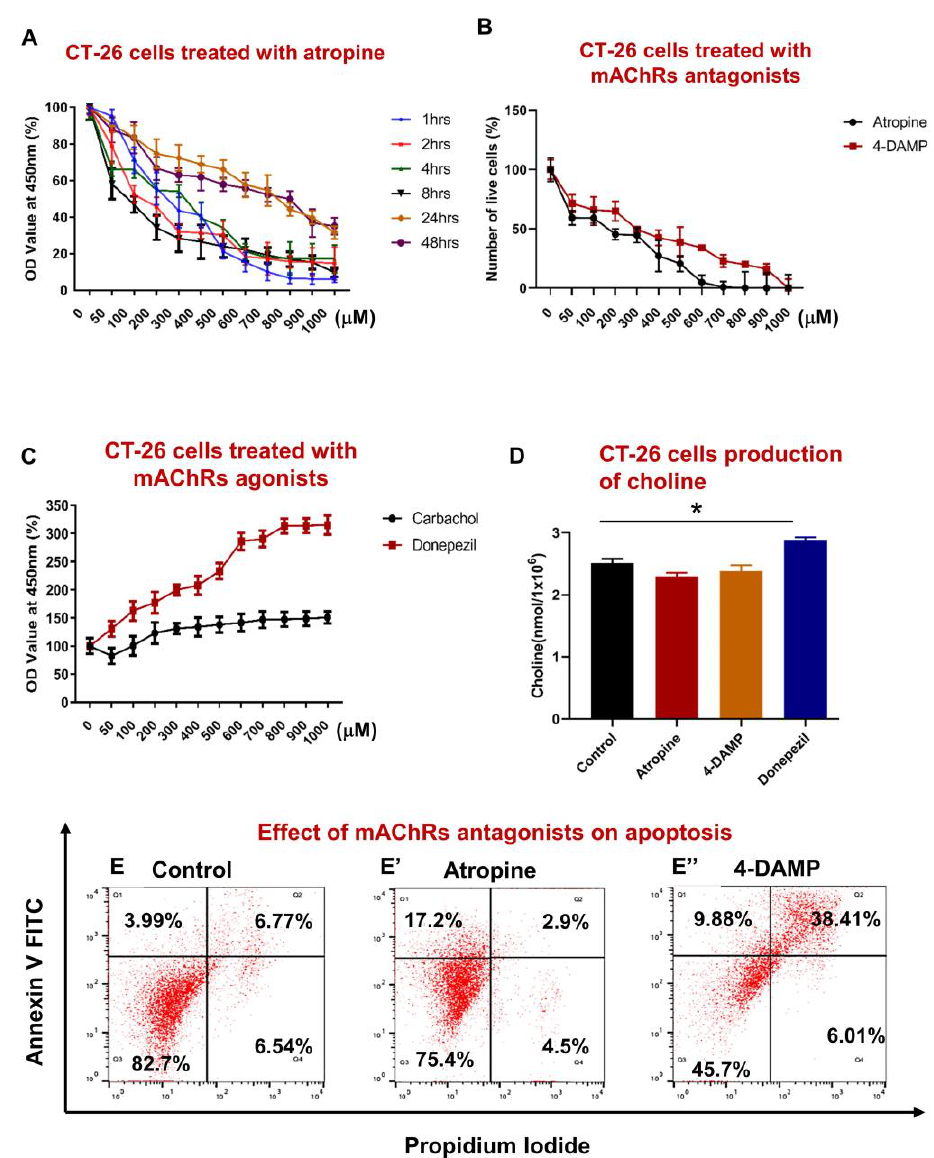
Figure 1. Effect of atropine and 4-DAMP on proliferation, apoptosis, and production of choline in CT-26 cells. CT-26 cells were treated with different concentrations of atropine at different time points ( A ). Number of viable cells after 8 h incubation with various concentrations of atropine and 4-DAMP ( B ). CT-26 cells were treated with various concentrations of carbachol and donepezil for 8 h ( C ). The amount of choline was measured in CT-26 cells treated with atropine, 4-DAMP, and donepezil ( D ). Annexin V-FITC/PI staining of CT-26 murine colon cancer cell line treated with control ( E ), atropine ( E ’ ), and 4-DAMP ( E ” ). Values in ( A – E ) are mean ± standard error of the mean (SEM) from at least three independent experiments performed in triplicate wells. Two independent experiments were performed in triplicates. Values presented as mean ± SEM from at least two independent experiments for choline assay. Two-way ANOVA followed by Tukey’s multiple comparison test was used and considered significant when * p < 0.05.